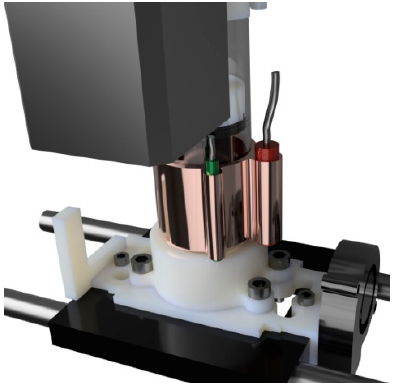
Figure 7. Copper sleeve for heater and temperature sensor.